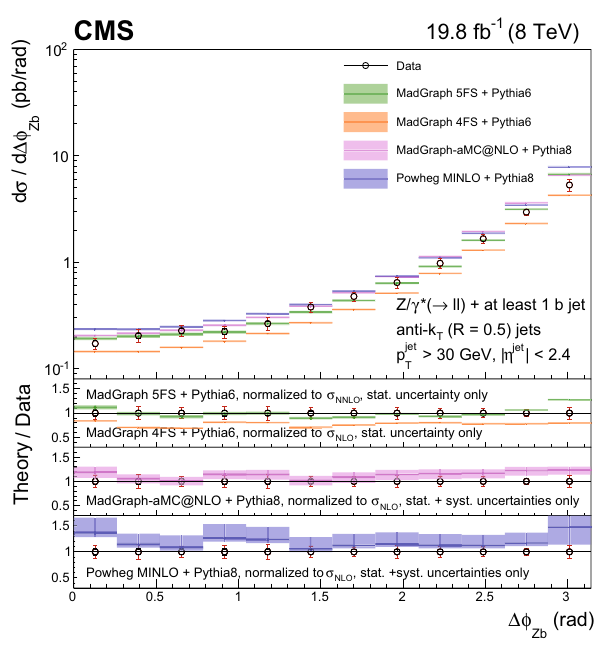
Fig. 8 Differential fiducial cross section for Z(1b) production as a function of Δφ Zb ( left ), and the cross section ratio for Z(1b) and Z+jets production as a function of Δφ Z ( b / j ) ( right ), compared with the MadGraph 5FS, MadGraph 4FS, MadGraph5 _a MC@NLO , and powheg minlo theoretical predictions ( shaded bands ), normalized to the theoretical cross sections described in the text. For each data point